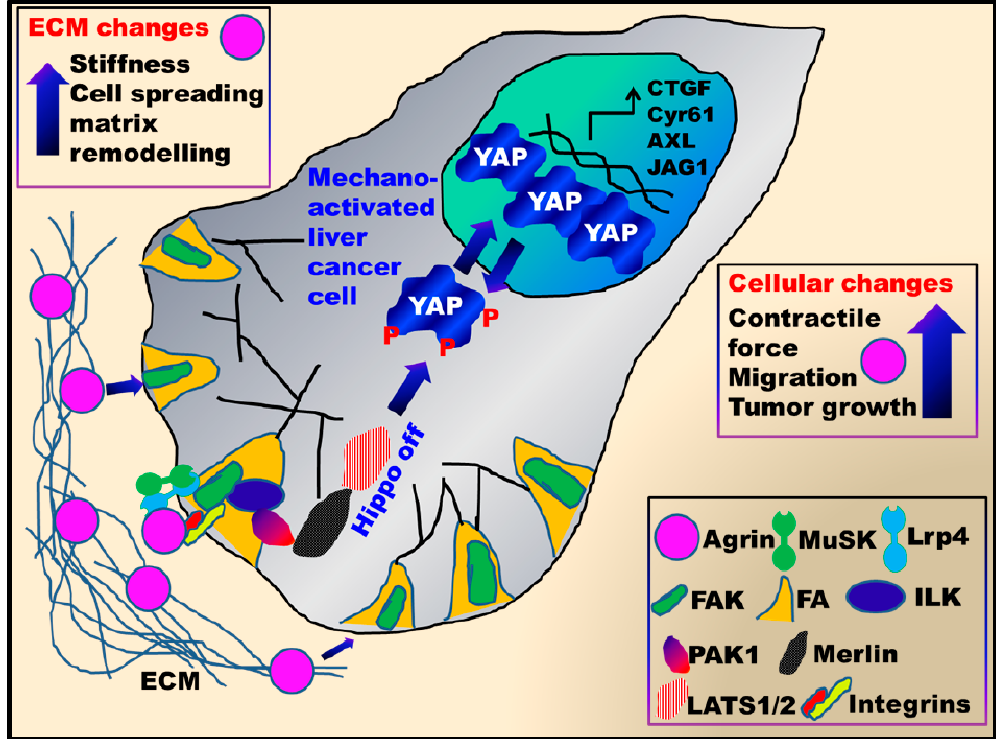
Figure 3. Coordinated mechanotransduction network involving agrin and YAP in liver cancer.